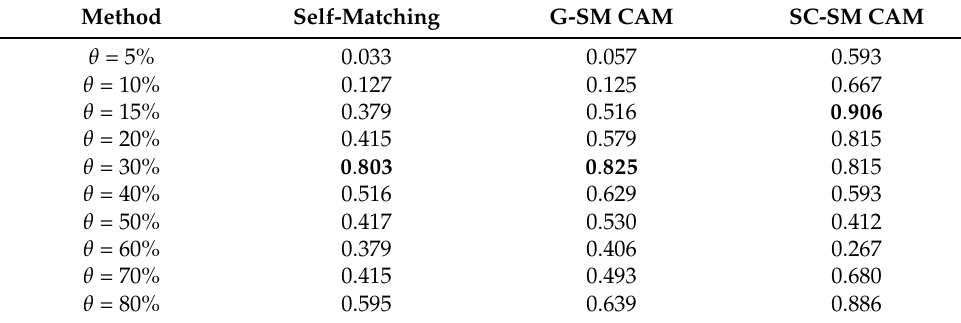
Table 2. Average AUC of each CAM method for all testing data with different θ